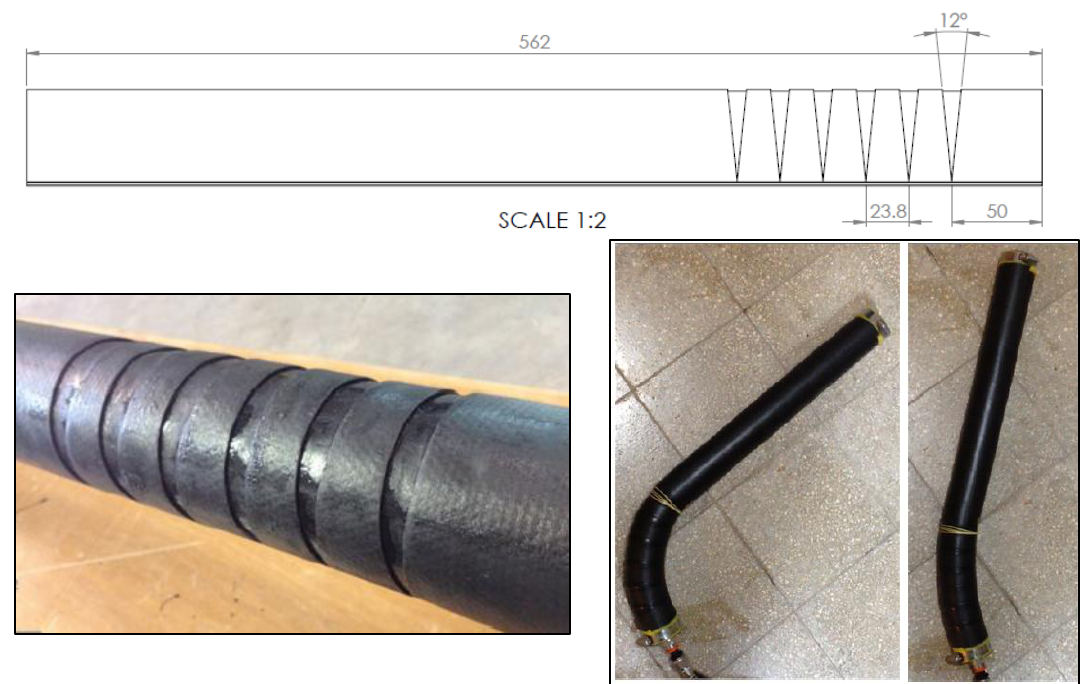
Figure 2. Clockwise from top: Layout of the third HELM prototype, HELM before and during bending, and the vulcanized hinge.